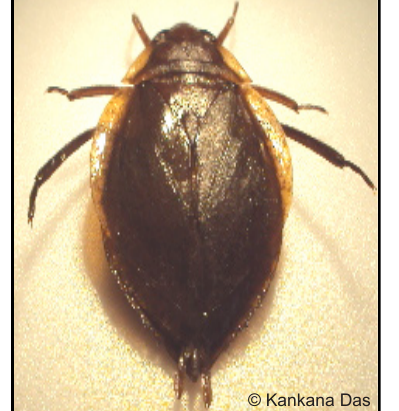
Image 14. Diplonychus rusticus (without eggs